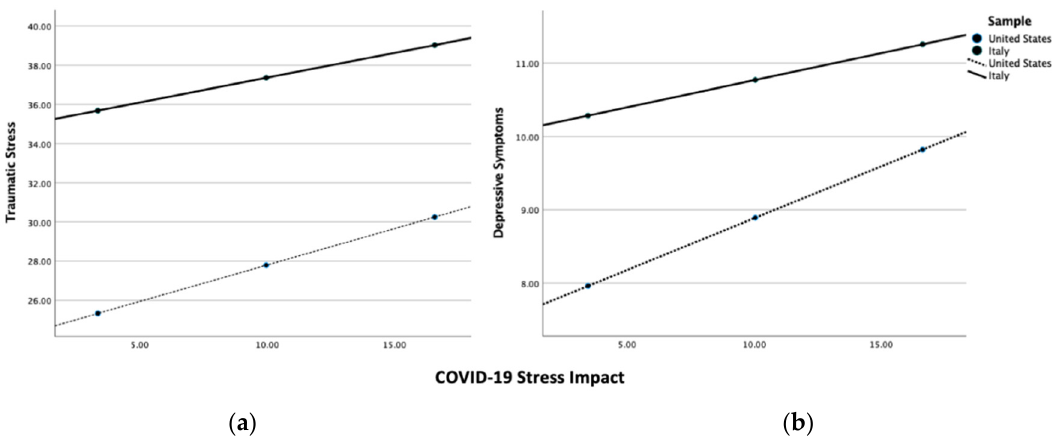
Figure 2. COVID-19 stress impact predicting traumatic stress and depressive symptoms by nationality. ( a ) First figure to the left showcases the association between COVID-19 stress impact with traumatic stress by nationality; ( b ) the second figure to the right showcases the association between COVID-19 stress impact with traumatic stress by nationality.